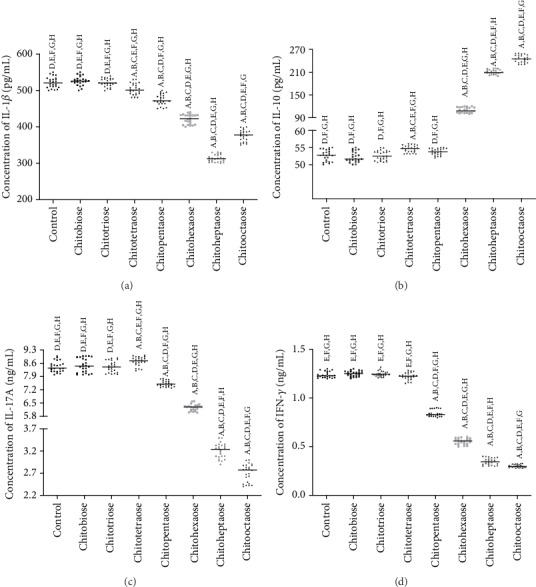
Anti-inflammatory effects of chitosan oligosaccharides (chitobiose, chitotriose, chitotetraose, chitopentaose, chitohexaose, chitoheptaose, and chitooctaose) in LPS inducing the release of inflammatory cytokines in RAW264.7 cells. (a) Interleukin- (IL-) 1β. (b) IL-10. (c) IL-17A. (d) Interferon- (IFN-) γ. Ap < 0.05 vs. the control, Bp < 0.05 vs. the chitobiose group, Cp < 0.05 vs. the chitotriose group, Dp < 0.05 vs. the chitotetraose group, Ep < 0.05 vs. the chitopentaose group, Fp < 0.05 vs. the chitohexaose group, Gp < 0.05 vs. the chitoheptaose group, and Hp < 0.05 vs. the chitooctaose group.